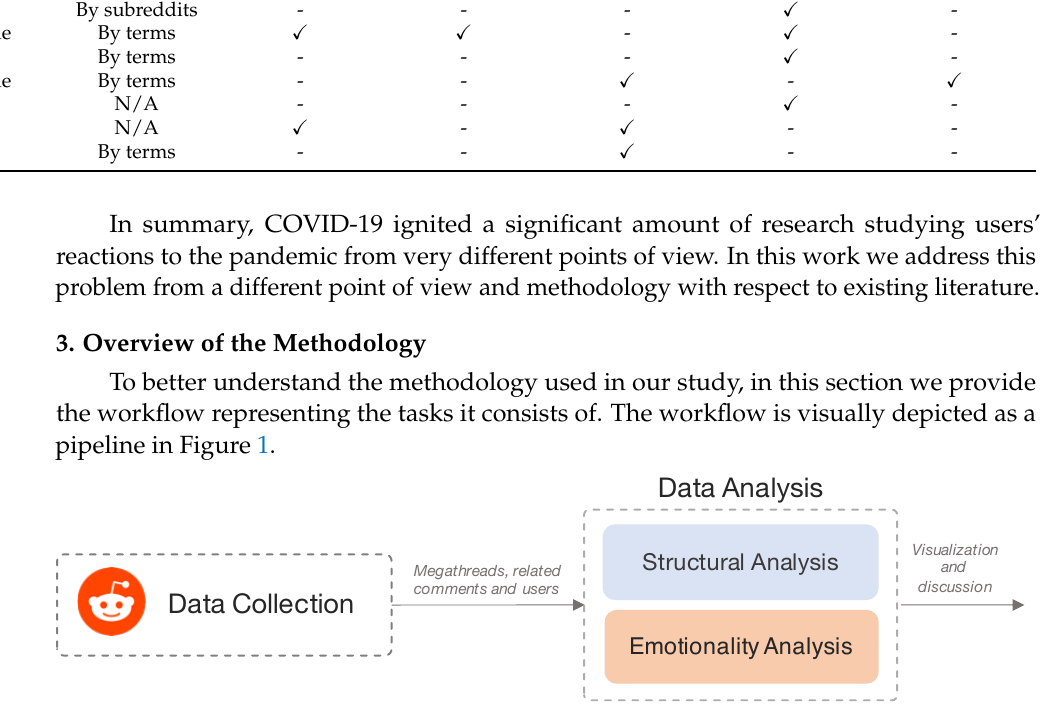
Figure 1. The workflow representing the tasks of our investigation (Reddit logo from https://www.